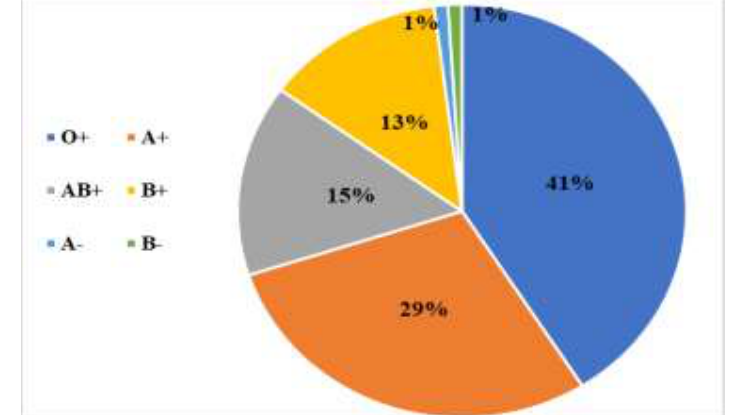
Figure 5: Blood groups distribution in 100 patients with